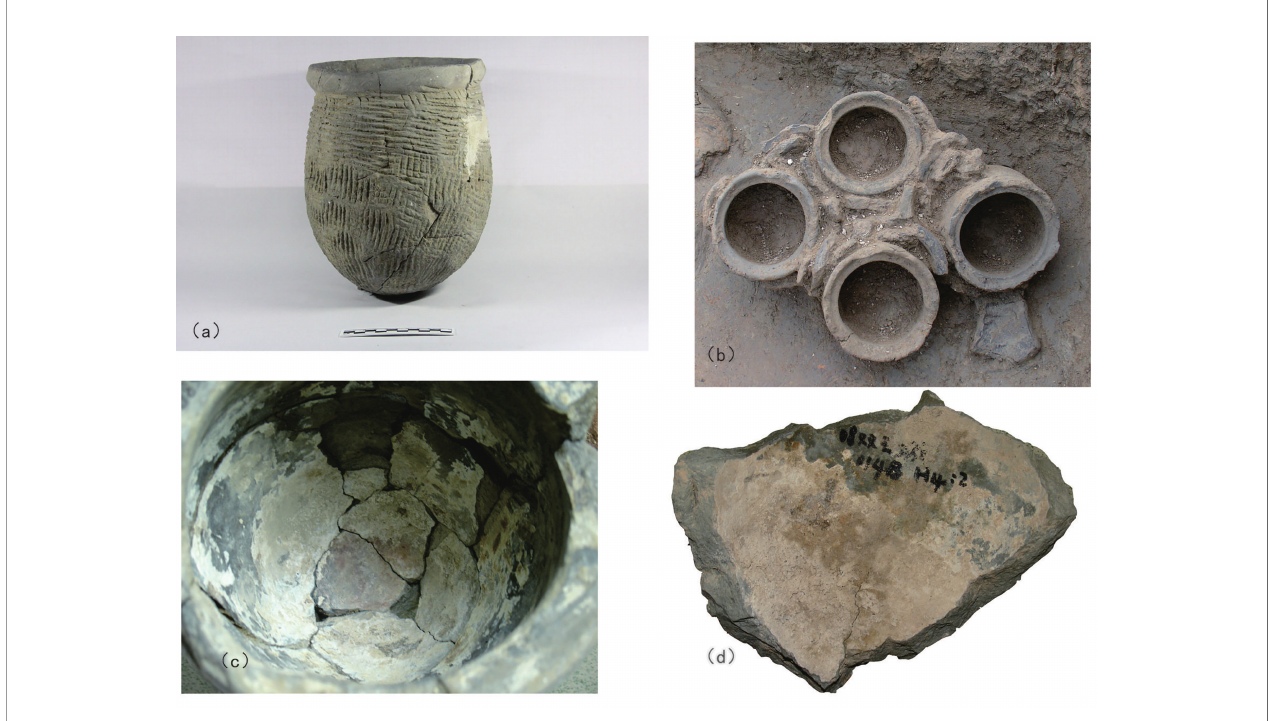
FIGURE 7 | Helmet-shaped potteries and white calcareous remains unearthed in southern plain of Laizhou Bay. (A) Helmet-shaped pottery of the Shang Dynasty unearthed at the Huangtuya site in Zibo city (provided by Zimeng Wang), (B) Helmet-shaped potteries unearthed at the SWC site, (C, D) White calcareous remains adhering to the inner wall of the helmet-shaped pottery at the SWC site (Yan,